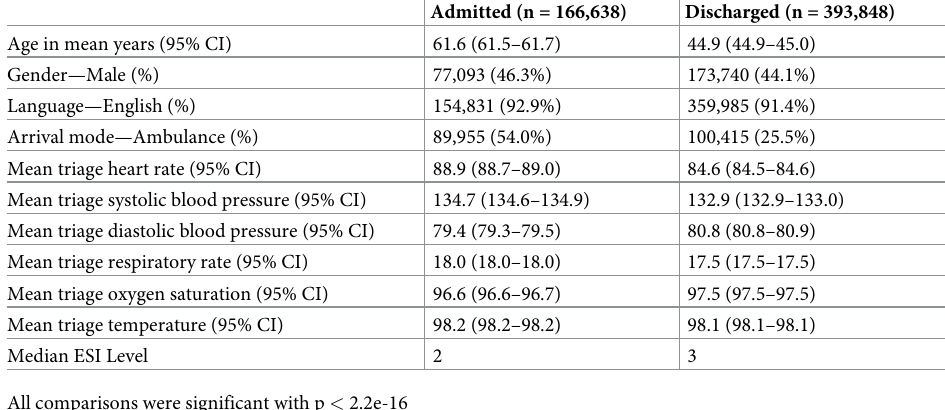
Table 2. Characteristics of study